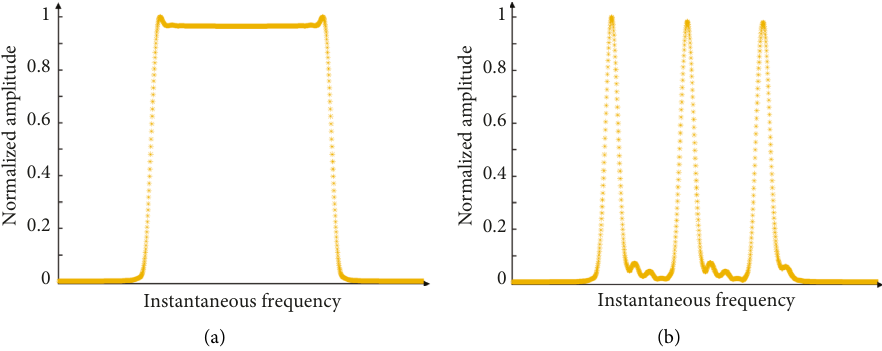
Figure 3: The instantaneous spectrums of target range gates. (a) Real target instantaneous spectrum. (b) ISRJ false target instantaneous